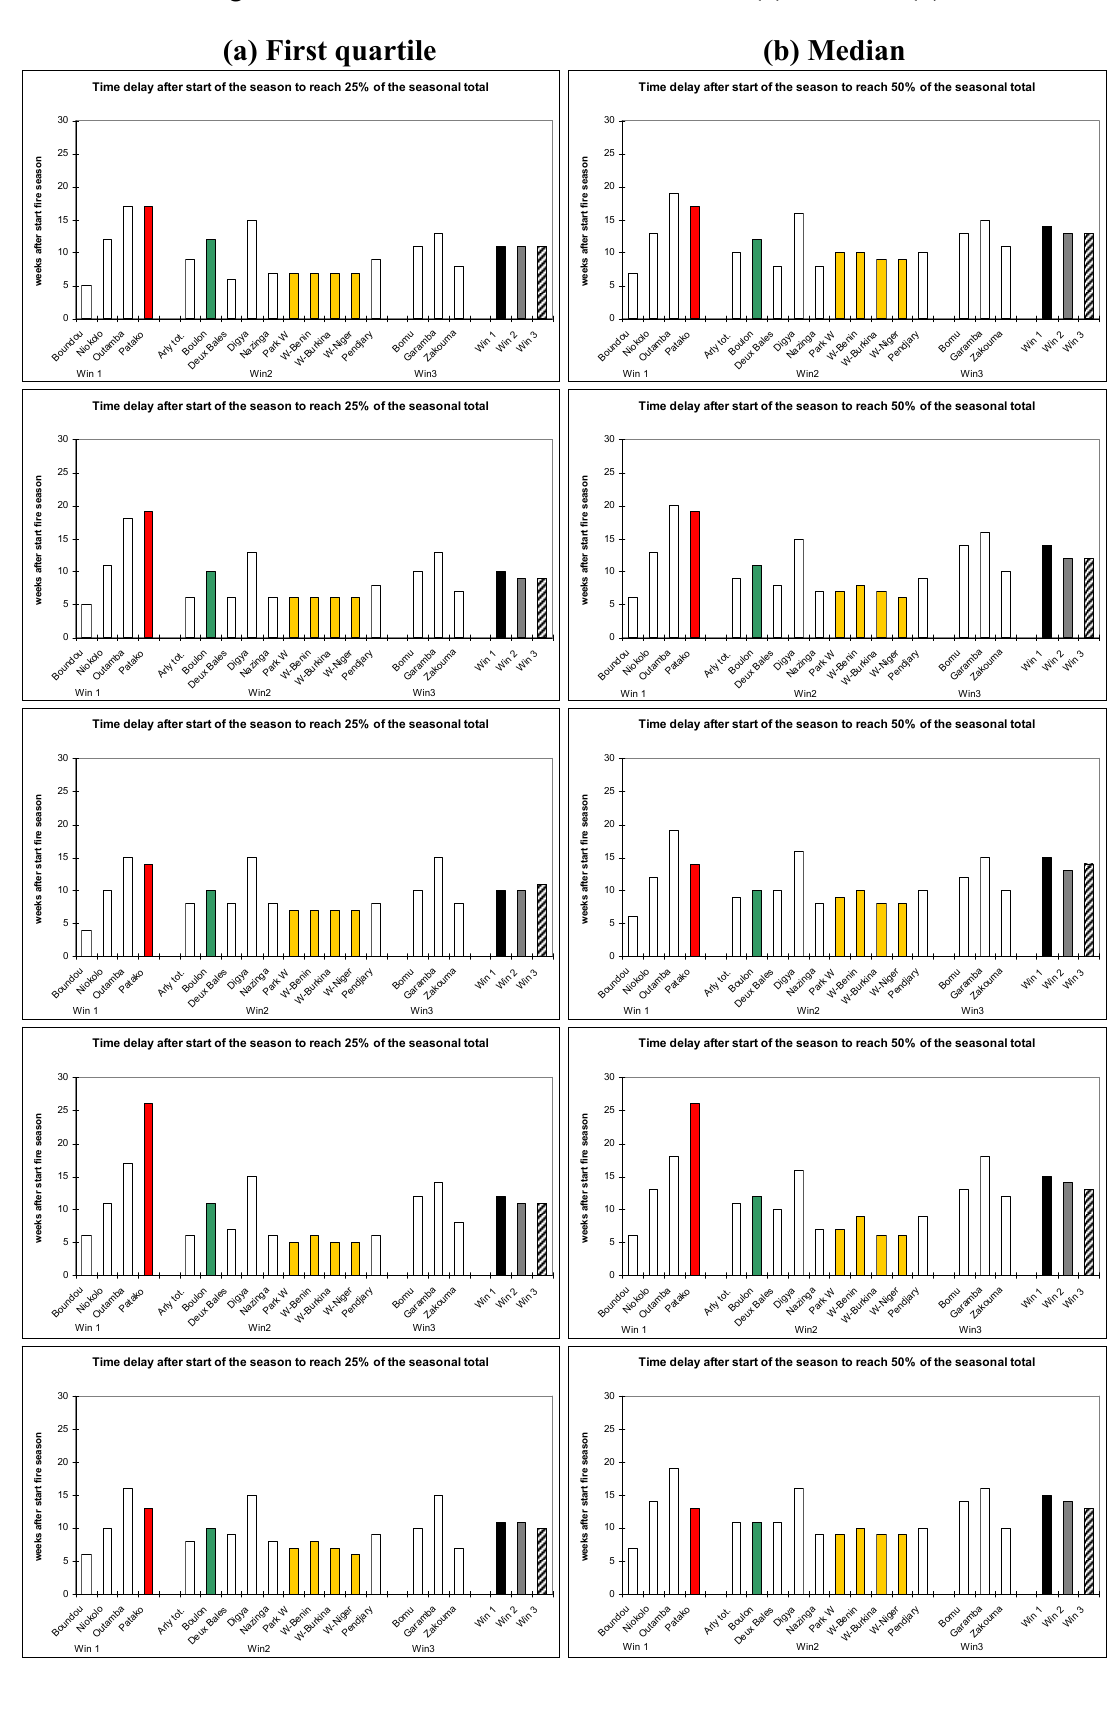
Figure 3. Fire distribution in Patako (red), Boulon (green), Park W (orange) and other 11 protected areas of West and Central Africa from 2004 to 2009. Number of weeks from the start of the burning season to reach 25% of the seasonal total (a) and 50% (b) . (a) First quartile (b) Median Time delay after start of the season to reach 25% of the seasonal